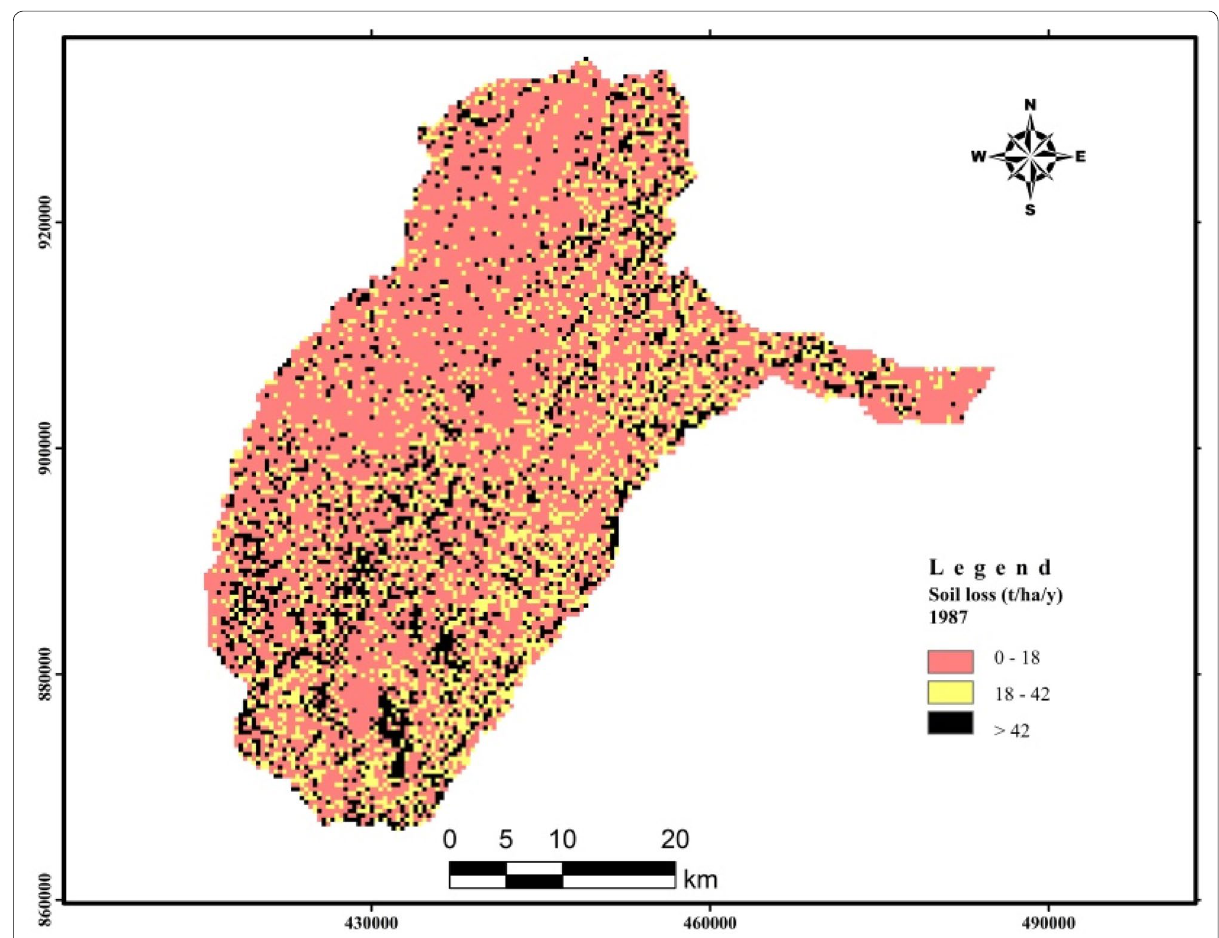
Fig. 14 Soil loss (ton ha − 1 year − 1 ) in 1987 (Source: